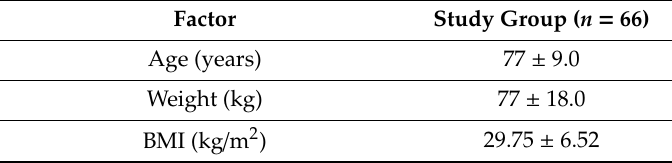
Table 1. Characteristics of the study group (ACEi—Angiotensin-converting-enzyme